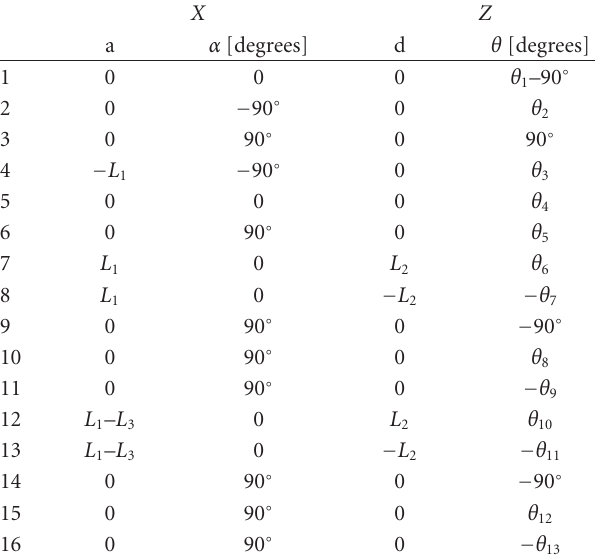
Table 1: D-H Dragonfly model.